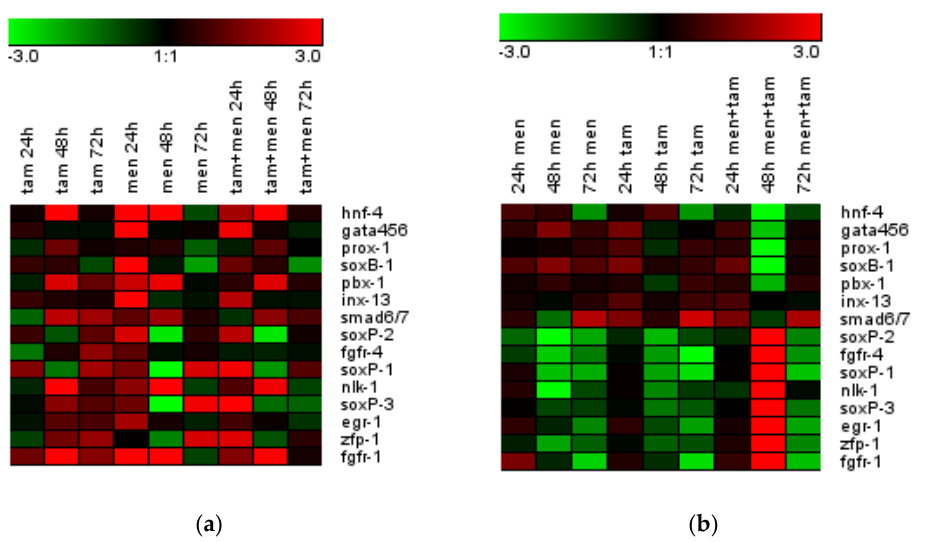
Figure 6. Tameron effect on expression of neoblast marker genes in intact ( a ) and regenerating ( b ) planarians. The figure shows heatmaps reflecting changes in expression of a test panel of neoblast marker genes in planarians after menadione-induced oxidative stress and/or treatment with Tameron compared to untreated animals. The scale of intensity of the standardized expression values extends from − 3 (green: low expression) to +3 (red: high expression). The 1:1 intensity value (black) represents the non-treated control. A non-treated control group was taken as a control. Menadione (Men) was used at working concentration of 10 − 6 M, Tameron (Tam)—10 − 4 M. The measurements were made on the 24 th , 48 th , and 72 nd h after treatment.